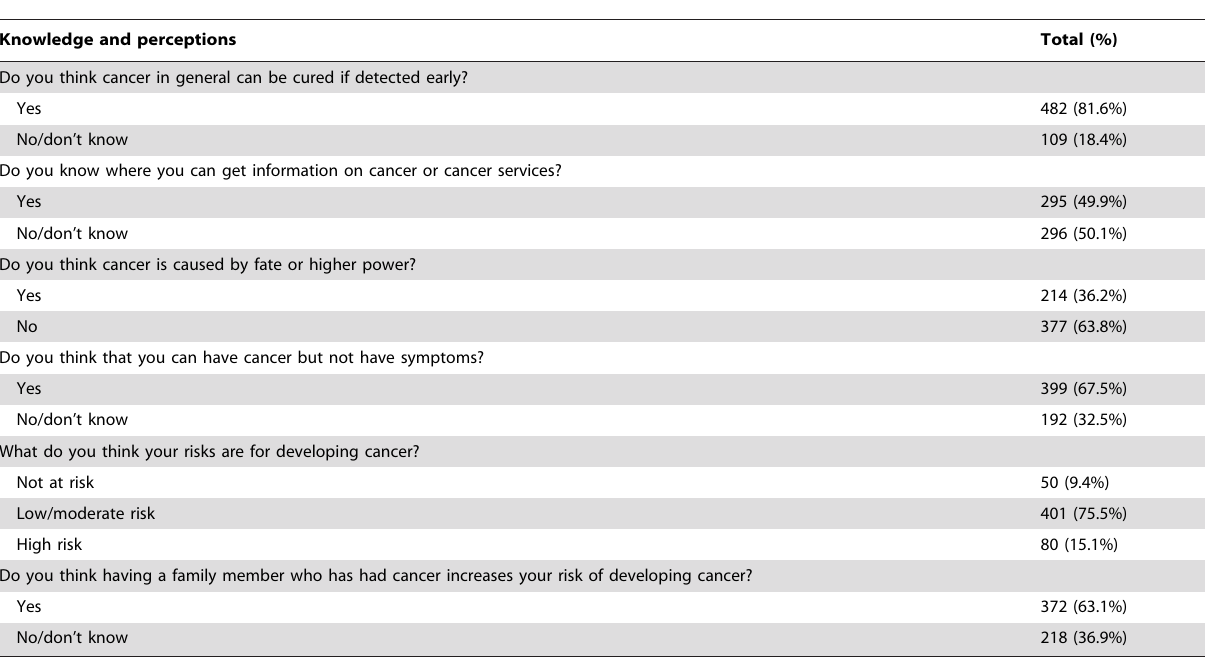
Table 4. Knowledge and Perceptions about Cancer among People with Severe Mental Illness.